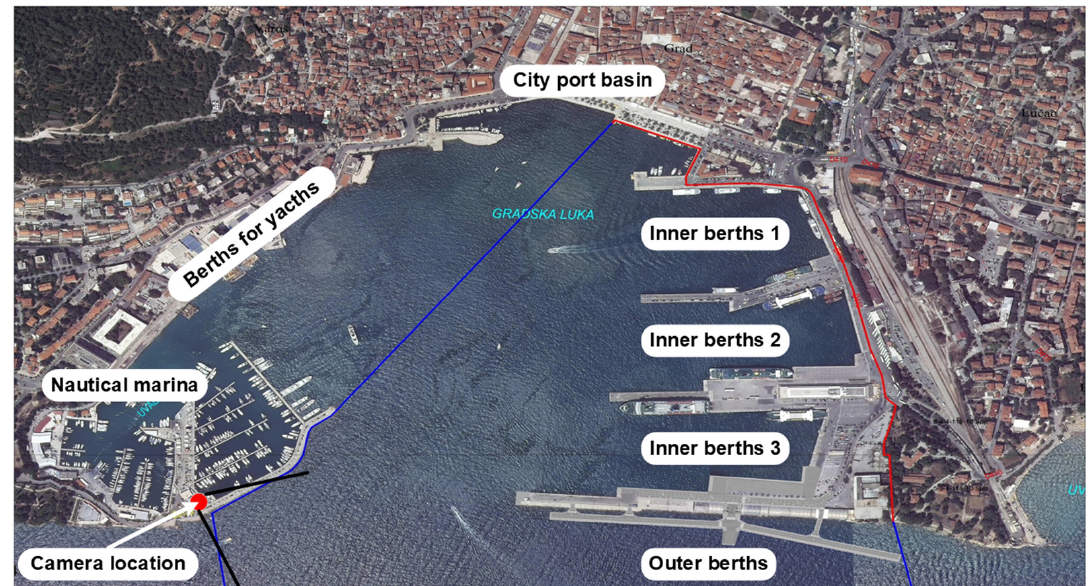
Figure 3. Adapted from [24]; generalized configuration of the Port of Split.